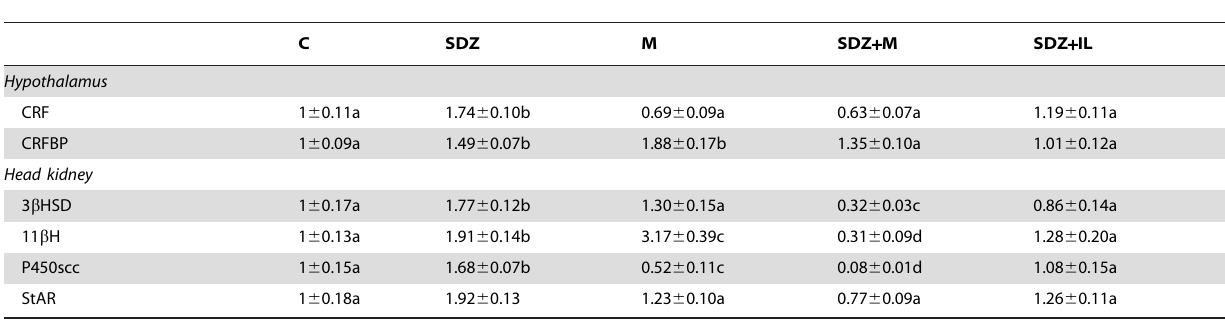
Data represent mean of 5 measurements. Data is expressed with respect to the control group (expression results were normalized by EF-1 a mRNA levels, which did not show changes among groups). Different letters indicate significant differences ( P , 0.05) among treatments. doi:10.1371/journal.pone.0113291.t003 PLOS ONE |